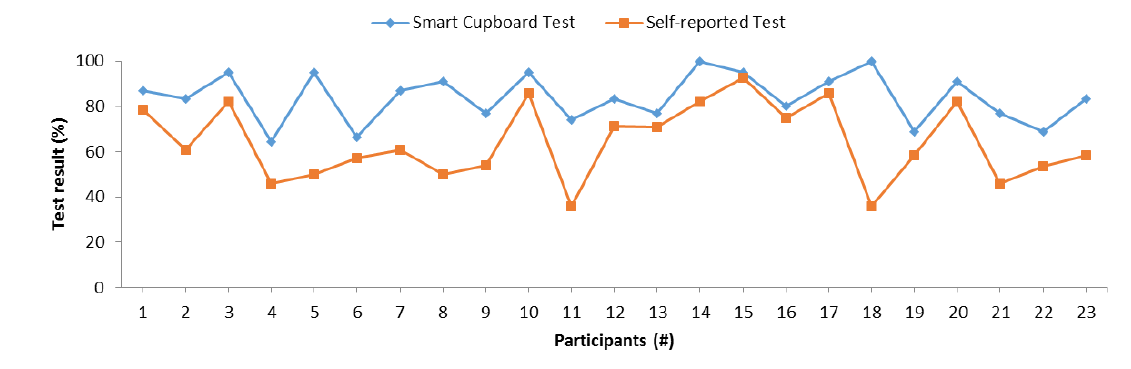
Figure 13. Comparison between the accuracy of SC and that of self-reported